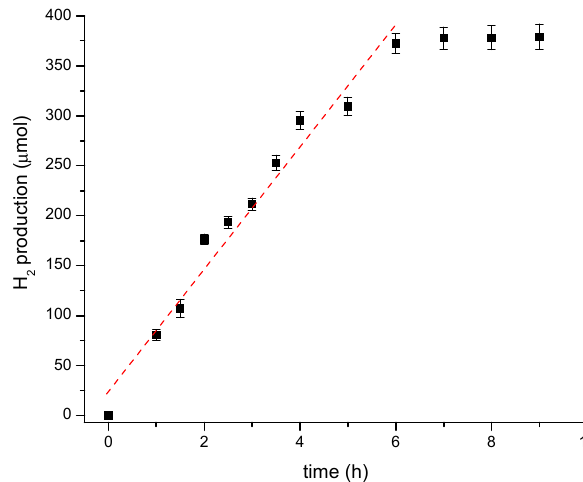
Figure 9. Light-driven hydrogen evolution over time generated using continuous light-visible irradiation of an aqueous solution containing G4-F nanoaggregates, Pt-ascorbate nanoparticles, ascorbate, and methyl viologen (V). The red dashed line represents the linear part of the kinetics of the H 2 evolution.